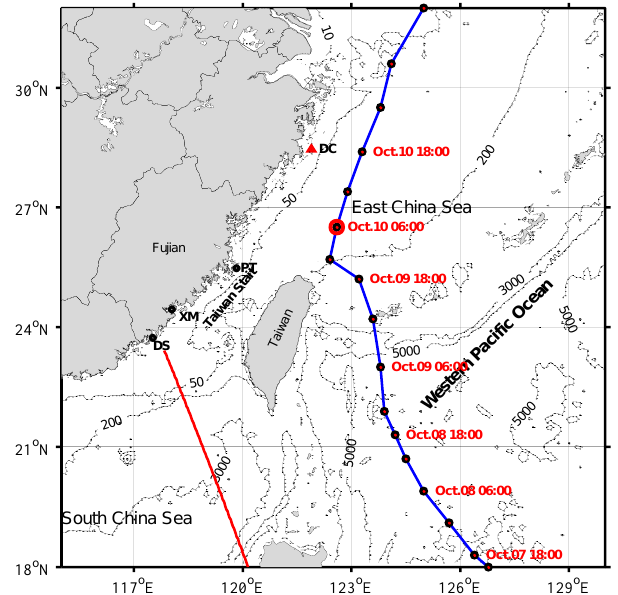
Figure 1. Map showing the study area off Southeast China with bathymetric contours in meters. Typhoon Seth’s track and locations at specific times are shown as blue lines and red dots. The red line is the TOPEX/Poseidon (T/P) satellite ground track. Pingtan (PT), Xiamen (XM) and Dongshan (DS) tide stations are marked by circles. The Dachen (DC) weather station is also depicted (red triangle).